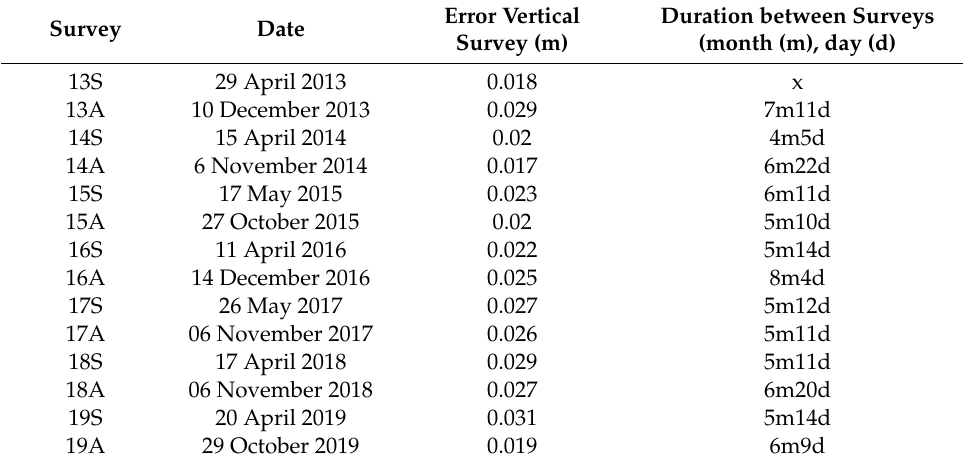
Table 1. Description of the LiDAR bi-annual surveys (S: spring, A: autumn season). Survey Date